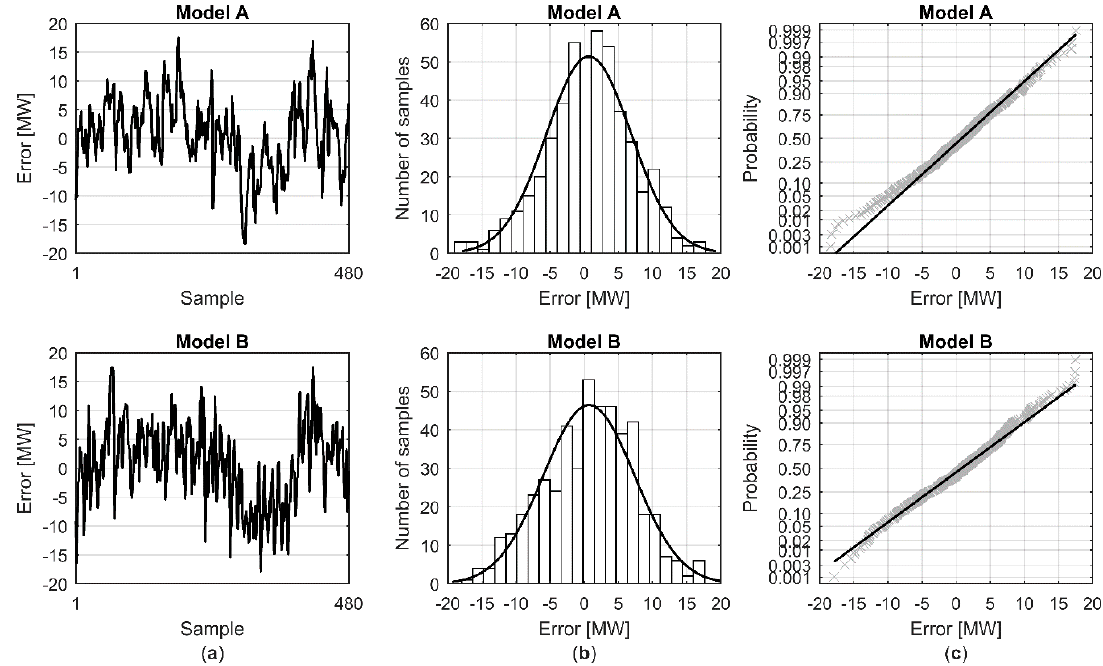
Figure 4. A box plot of the hourly absolute percentage error (APE) for the total heat demand forecast during the 48-h prediction horizon with ten validation data sets for ( a ) model A and ( b ) model B. For each box, the edges are the 25th and 75th percentiles, the central line marks the median, the dashed lines extend to the most extreme data points not considered outliers and the crosses mark the outliers.